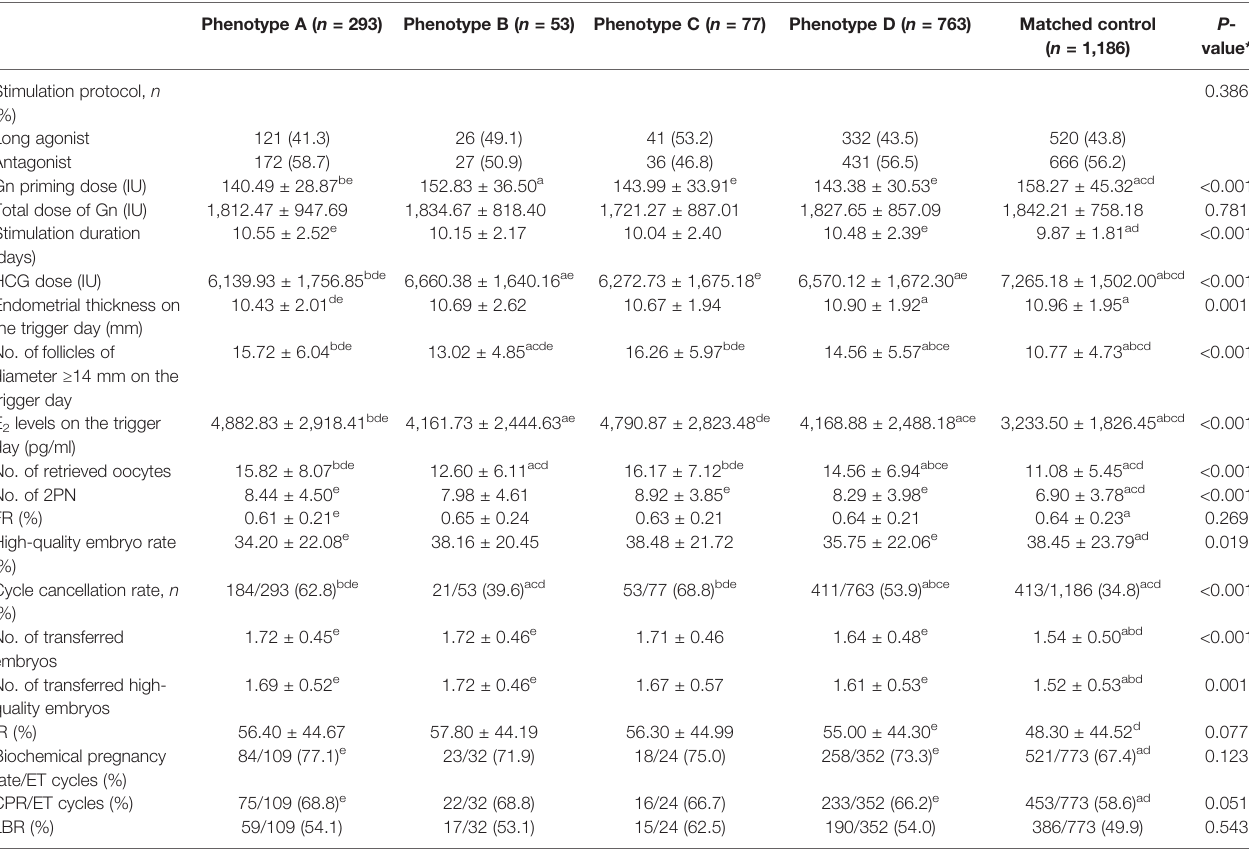
TABLE 2 | Comparison of ovarian response and pregnancy outcomes among the four PCOS phenotype groups and the control group.